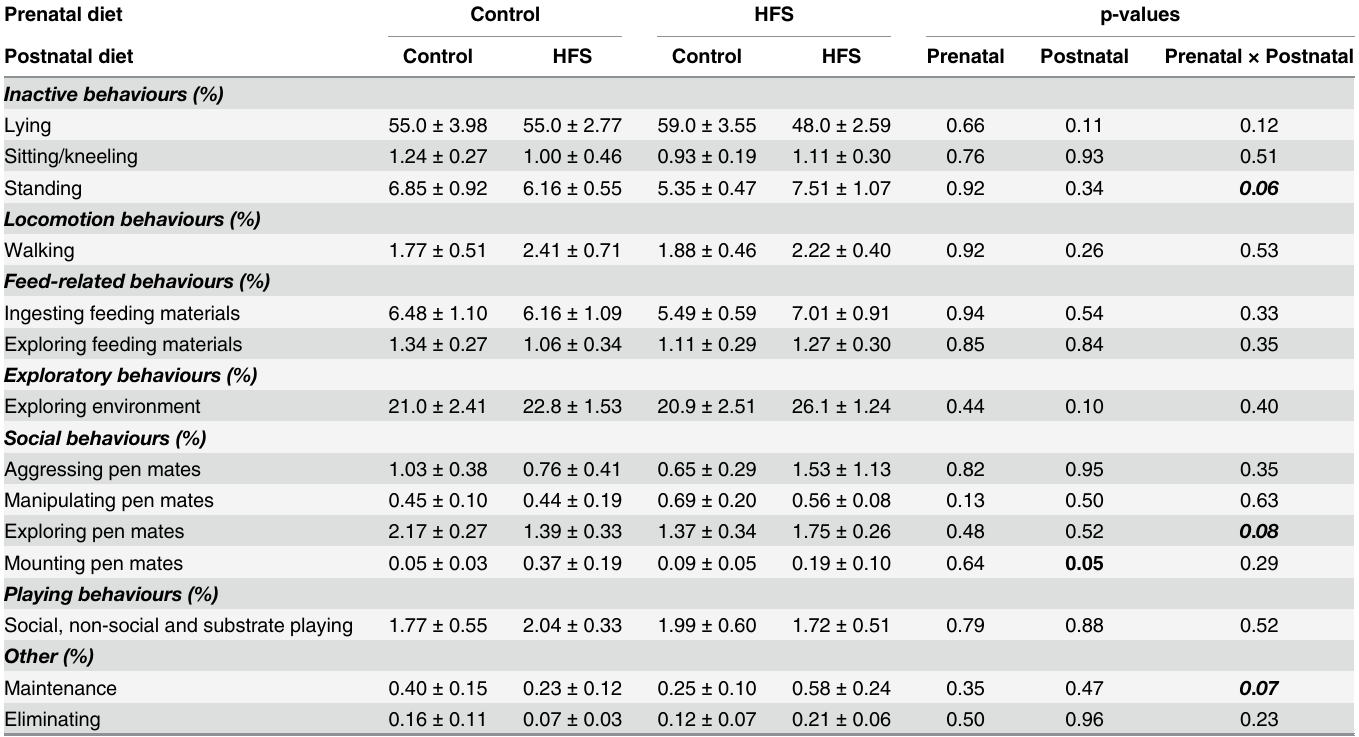
Table 3. Behavioural activity of piglets in the home pen the day after weaning. Prenatal